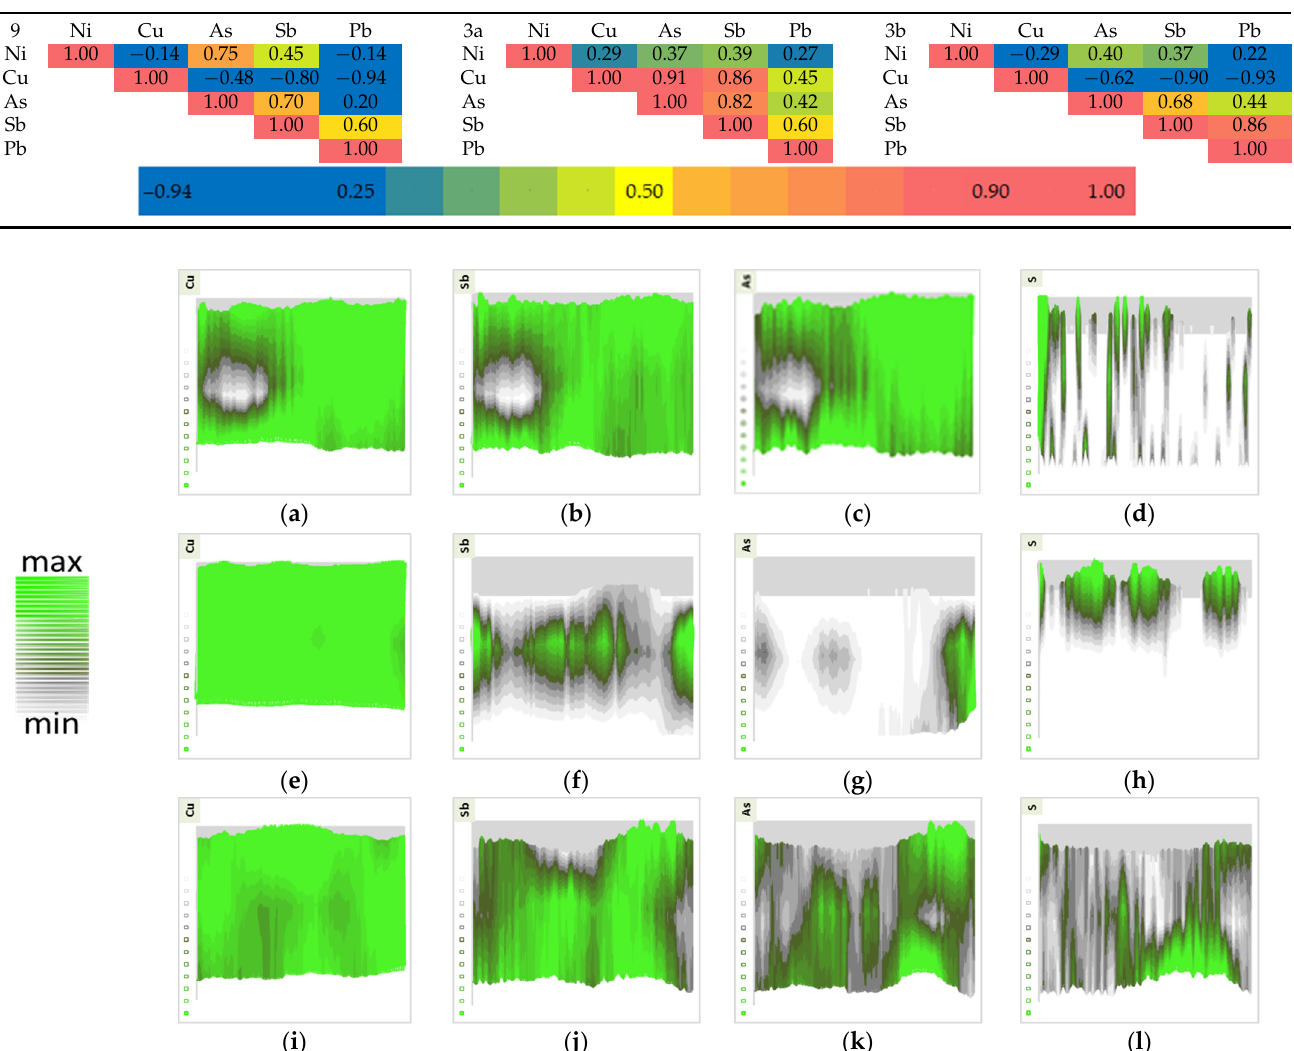
Table 4. Calculated correlation coefficients in the mineral samples (3a, 3b, 9).